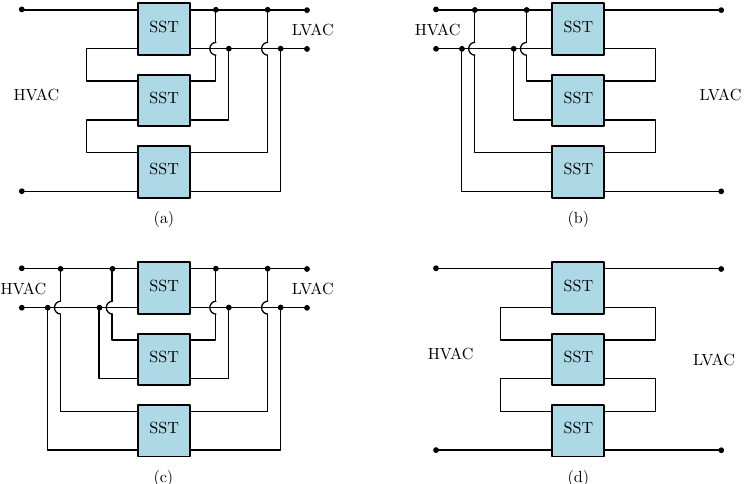
Figure 8. Different topologies of SST from the input/output connection of power electronic converters point of view: ( a ) ISOP; ( b ) IPOS; ( c ) IPOP; ( d )